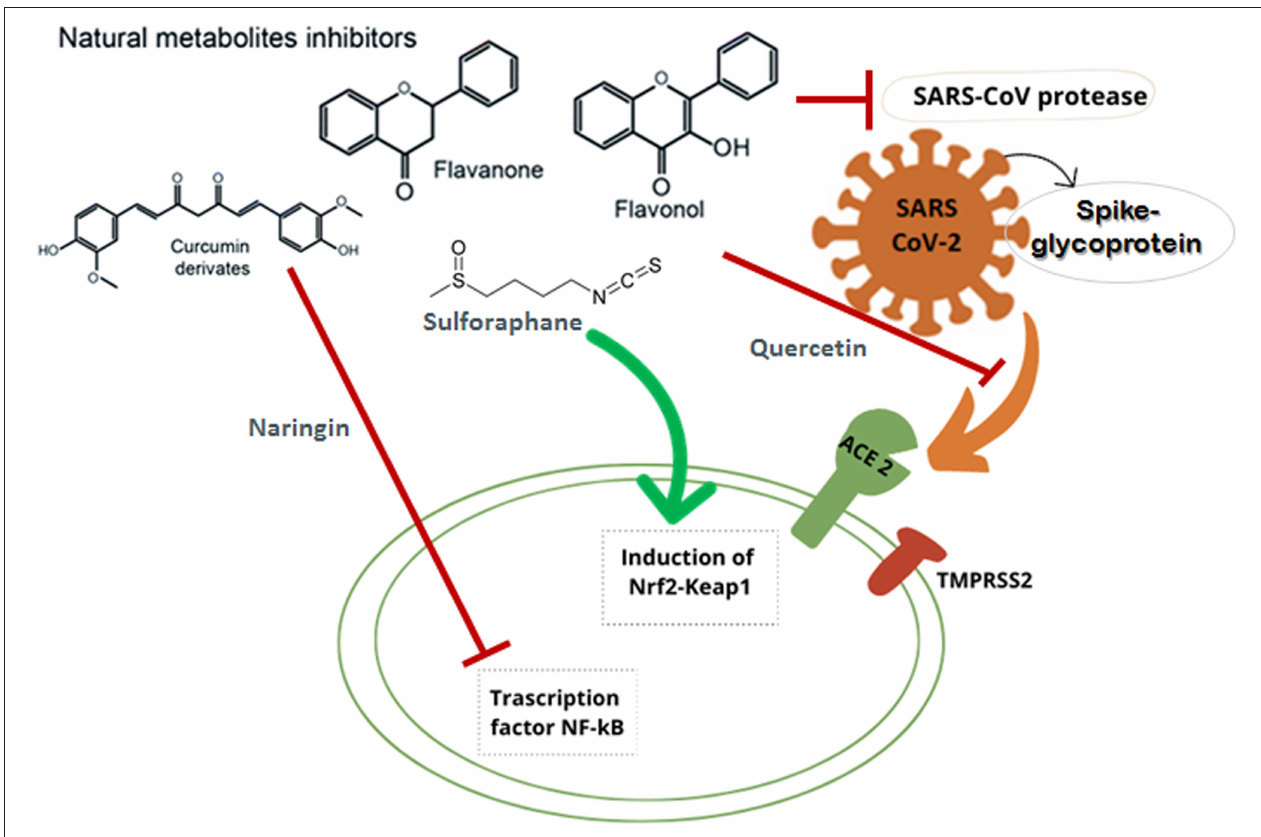
FIGURE 1 | Schematic representation of the main mechanisms of action against SARS CoV-2 of different secondary plant metabolites: flavanones, flavonols, aromatic compounds, and sulfur compounds.